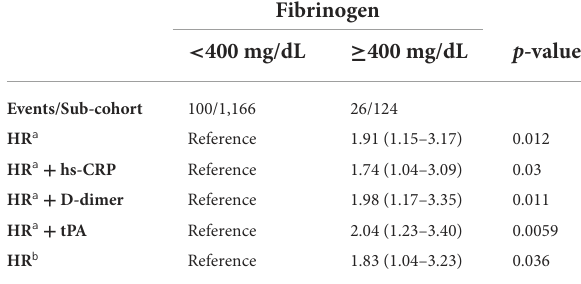
TABLE 3 HRs (95% CI) for developing colorectal cancer according to levels of fibrinogen < or ≥ 400 mg/dL adding inflammatory and hemostasis biomarkers in the